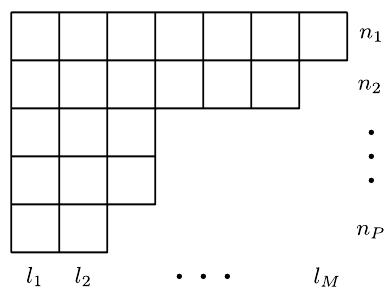
Figure 8 . Young tableau labelling the irreducible representations of U(N).